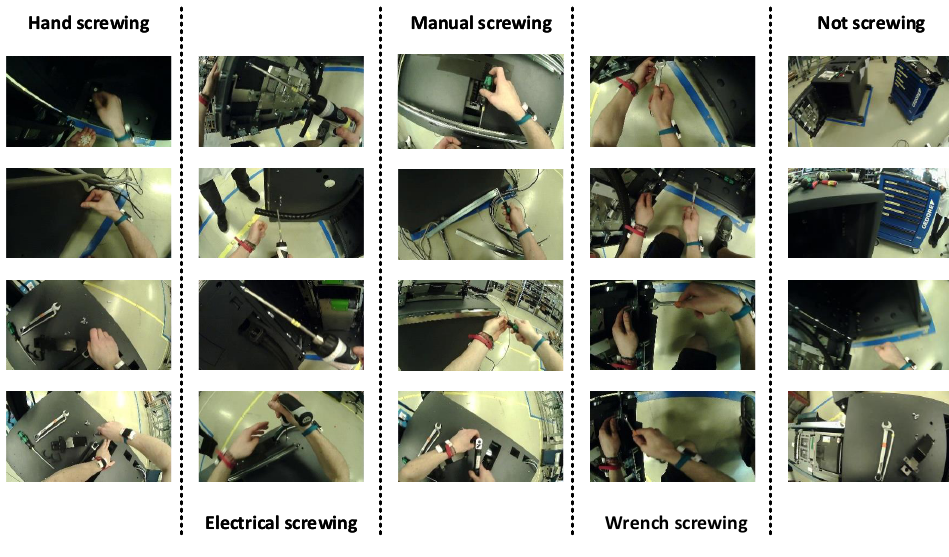
Figure 8. Samples of each